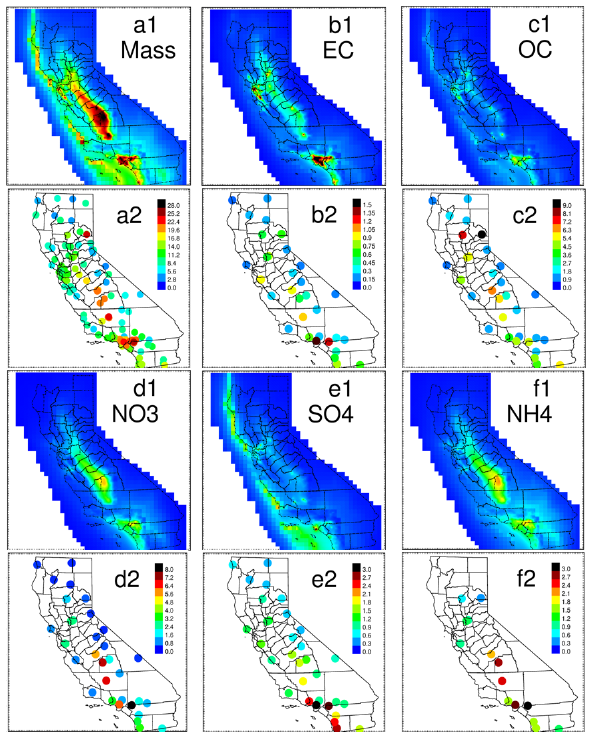
Figure 10. Predicted (1) vs. measured (2) 9-year average PM 2 . 5 total mass (a) , EC (b) , OC (c) , nitrate (d) , sulfate (e) , and ammo- nium (f) concentrations. The SoCAB_4km and SJV_4km results are overlayed on top of CA_24km results to create the model pre- dicted spatial distributions. Predicted and measured concentrations of the same species are in the same scale shown in the measurement